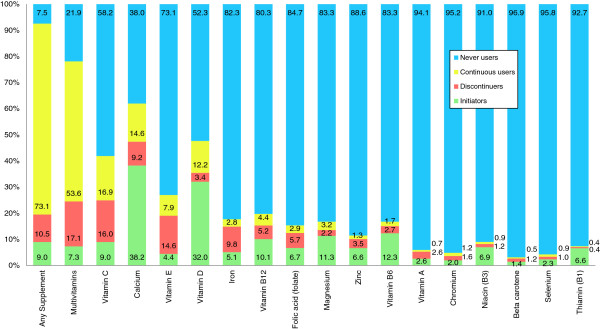
Change in supplement use from breast cancer diagnosis to 6 months post diagnosis. For each type of dietary supplement, this figure displays the percent of participants who were never users (blue), continuous users (yellow), discontinuers (red) and initiators (green) from the time of breast cancer diagnosis to 6 months post diagnosis.